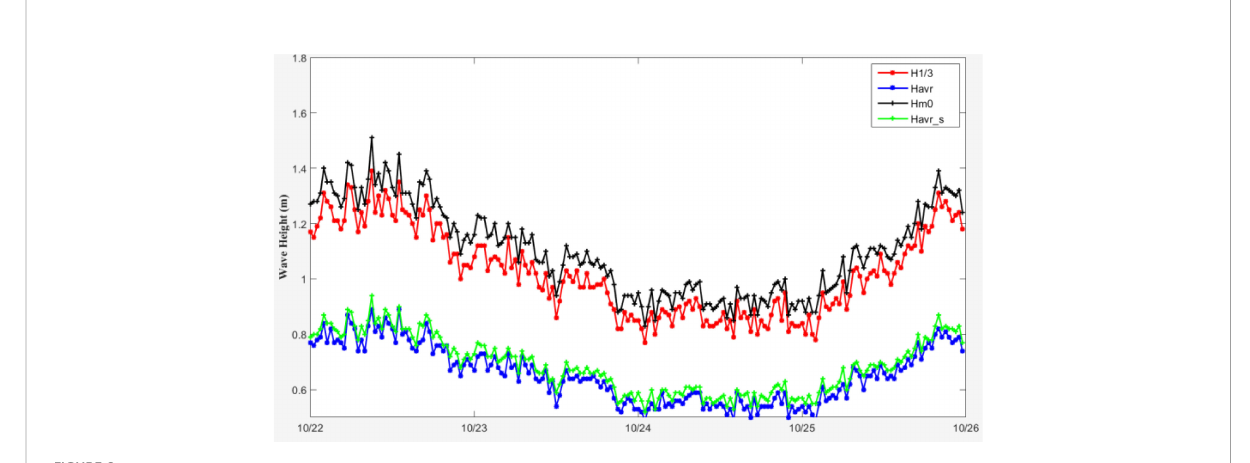
FIGURE 8 Comparison of time and frequency wave height.